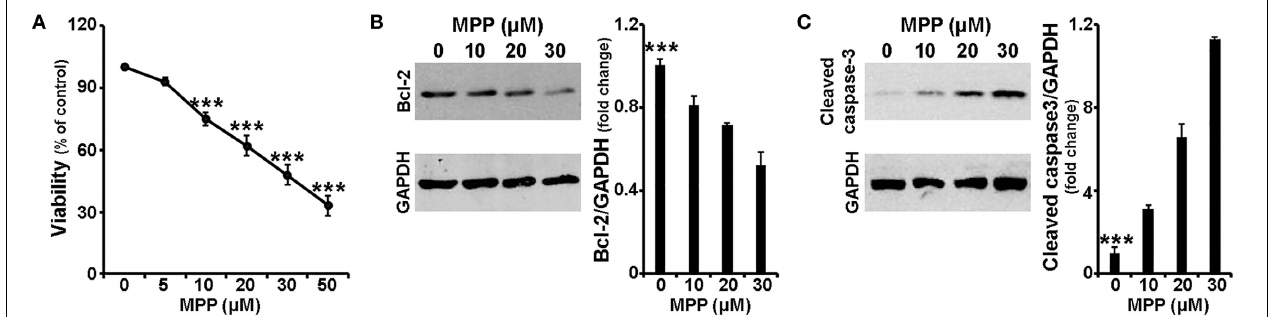
and immunoblotted with antibodies specific for BCL-2 (B) and cleaved caspase-3 (C) . To ensure equal loading, membranes were re-probed against GAPDH. Note that compared to untreated controls, primary cortical neurons treated for 24h with MPP + displayed a dose-dependent decrease of BCL-2 protein levels, as well as a dose-dependent increase of cleaved caspase-3 protein levels. Quantification of the results in (B,C) was performed by scanning densitometry. Bars in all the presented graphs depict mean ± s.e.m. ∗∗∗ P ≤ 0 . 001.